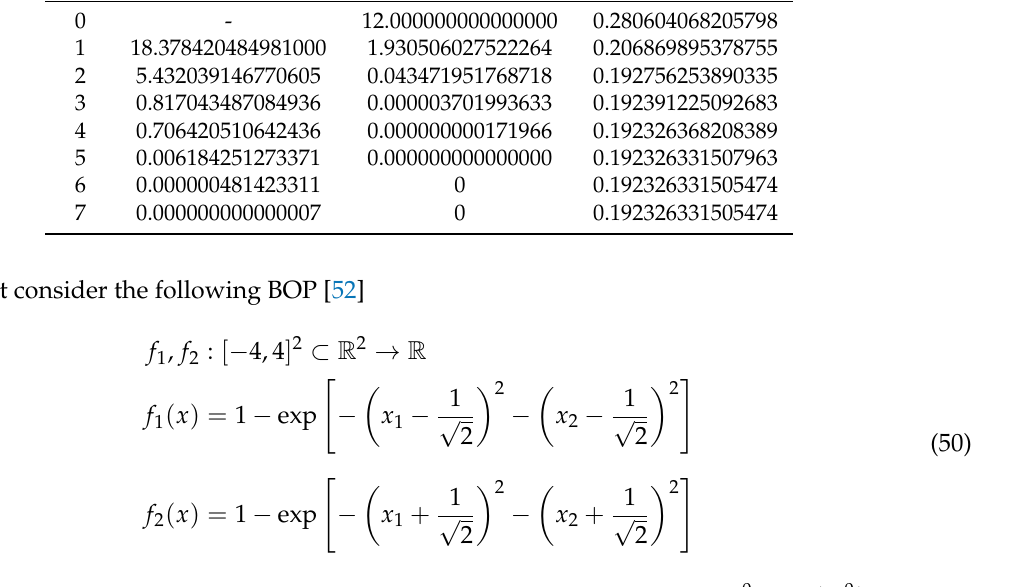
-Newton method on BOP (27). ( Right ) image of the final 2 -Newton method for BOP (27), see Figure 8. 2